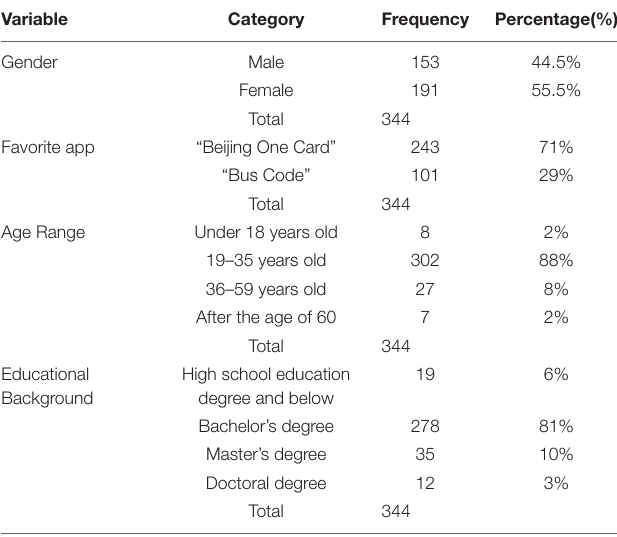
TABLE 2 | A statistical table of the basic situation of